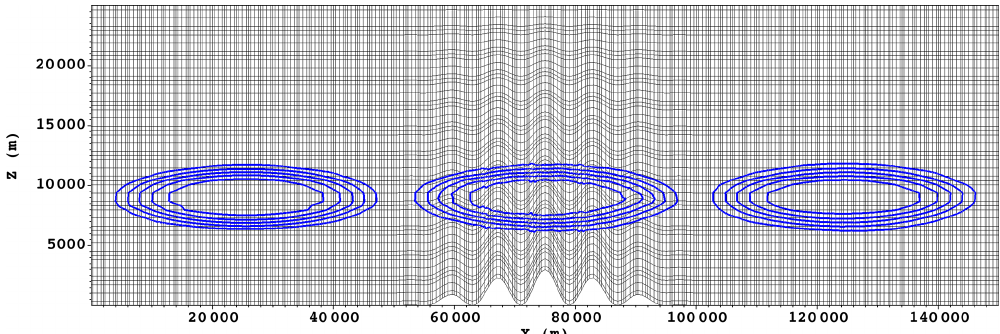
Figure 5. Solution of the passive transport of scalar χ at three different time instances, with contours of tracer quantity χ (from 0, outermost contour, to 1, innermost contour) overlaid on a representation of nodal points on the underlying mesh. Tracer advection is driven by a prescribed velocity profile from left to right. As it crosses the deformed grid above the mountain ridge, only a minimal distortion of tracer contours is observed, which is completely recovered back to a smooth solution downwind of the